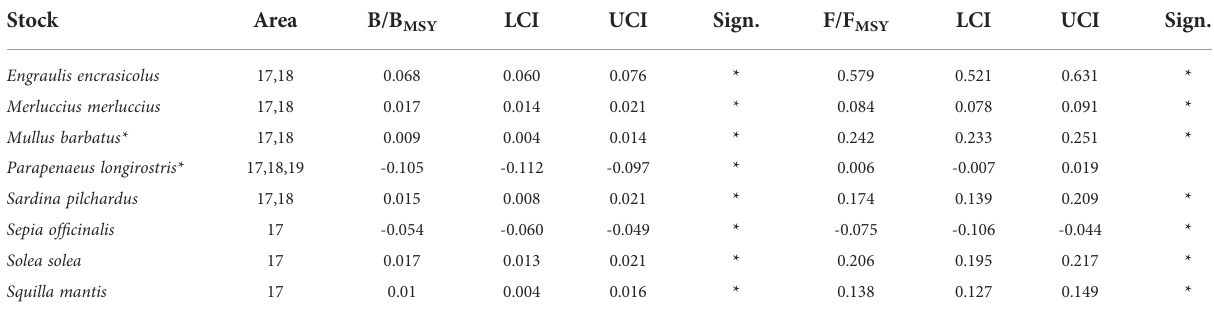
LCI and UCI represent the lower andupper 95%con fi dence interval limit, respectively. A difference isconsidered statistically signi fi cant when its con fi dence interval does notinclude 0. In the table, these differences are highlighted in bold and marked with the * symbol in the “ Sign. ” Column.